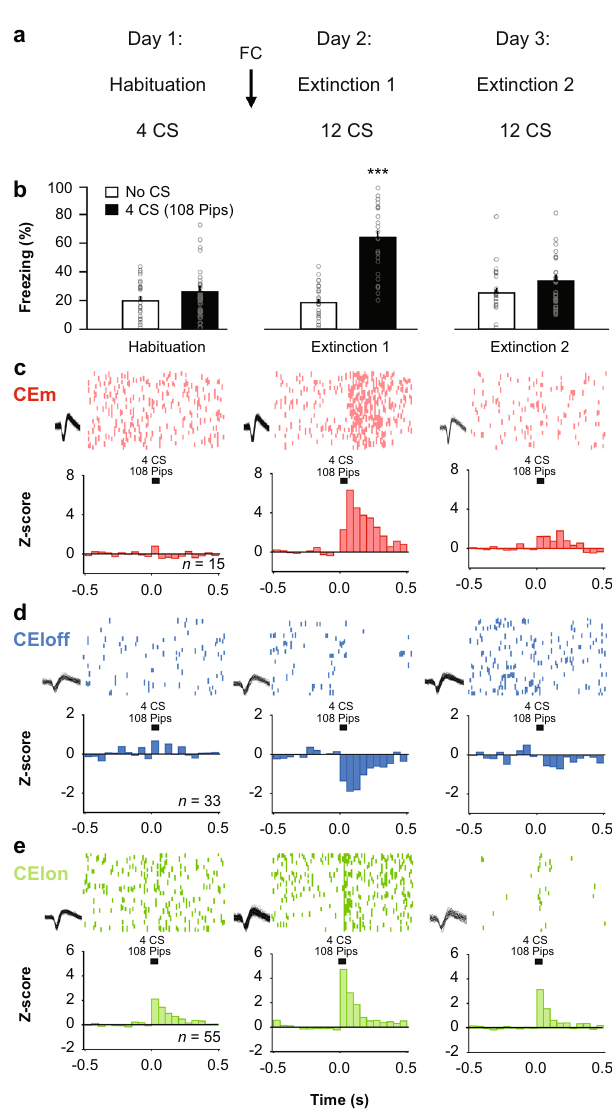
Fig. 1 Neuronal correlates of fear extinction in subpopulations of CEA neurons. a Behavioural protocol. FC: fear conditioning. CS: conditioned stimuli. b Behavioural data. B6 mice: n = 27; freezing, habituation, no CS: 19.8 ± 2.6%, CS: 26.1 ± 3.3%, beginning of extinction 1, no CS: 18.5 ± 2.3%, CS: 61.9 ± 4.6%, end of extinction 2, no CS: 25.3 ± 3.1%, CS: 34.1 ± 3.4%, blocks (averages) of 4 CSs. One-way repeated-measures ANOVA F = 30.8, p < 0.001, followed by post hoc Bonferroni t -test vs. CS (5,130) group during habituation, p < 0.001. Bar plots are expressed as means± SEM. Circles are freezing values of individual mice. c Raster plots and corresponding spike waveforms of a representative CEm unit (top). Normalized and averaged population peri-stimulus time histograms (bottom). CEm neurons: n = 15 units from 5 mice; z -score habituation: − 0.11 ± 0.45, beginning of extinction 1: 4.21 ± 1.75, end of extinction 2: 1.24 ± 0.48, blocks of 4 CSs. One-way repeated-measures ANOVA F (2,28) = 3.9, p = 0.033 followed by post hoc Bonferroni t -test vs. during habituation, p = 0.023. d Raster plots and corresponding spike waveforms of a representative CEloff unit (top). Normalized and averaged population peri-stimulus time histograms (bottom). CEloff neurons: n = 33 units from 18 mice; z -score, habituation: 0.28 ± 0.33, beginning of extinction 1: − 1.53 ± 0.28, end of extinction 2: − 0.46 ± 0.34, blocks of 4 CSs. One-way repeated-measures ANOVA F (2,64) = 8.4, p < 0.001 followed by post hoc Bonferroni t -test vs. during habituation, p < 0.001. e Raster plots and corresponding spike waveforms of a representative CElon unit (top). Normalized and averaged population peri-stimulus time histograms (bottom). CElon neurons: n = 55 units from 15 mice; z -score, habituation: 1.30 ± 0.30, beginning of extinction 1: 2.54 ± 0.43, end of extinction 2: 1.40 ± 0.30, blocks of 4 CSs. One-way repeated-measures ANOVA F (2,108) = 5.3, p = 0.006 followed by post hoc Bonferroni t -test vs. during habituation, p = 0.008. All individual neurons of each CEA population had signi fi cant z - score values upon CS presentation (4 fi rst CSs during extinction 1). Source data are provided as a Source data fi